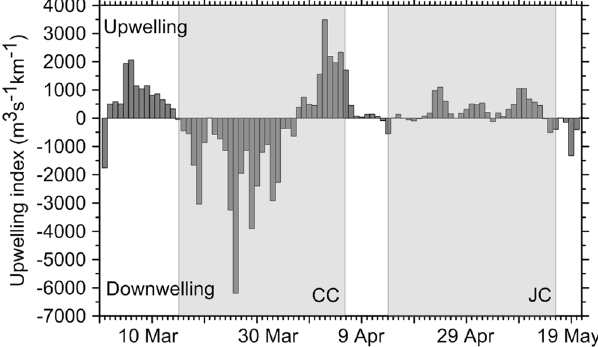
Figure 3. Daily upwelling index calculated at 44°N, 9°W, from the 1 March to 20 May 2010. Shaded regions denote the time of the cruises (CC, CAREVA cruise; JC, JUREVA